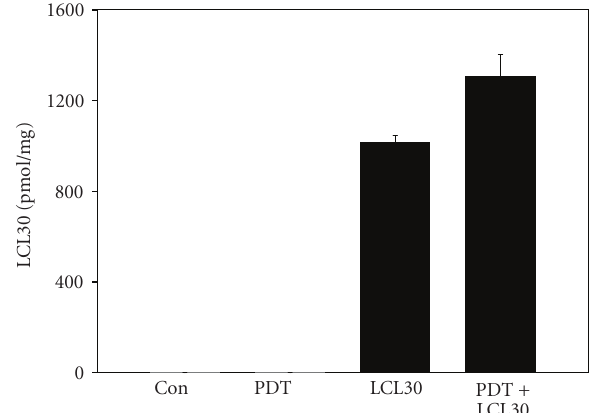
Figure 2: LCL30 is taken up by SCCVII cells treated with LCL30 or (PDT+LCL30). (PDT+LCL30): following overnight exposure to Pc 4 (250nM), cells were treated with LCL30 (1 μ M) for 2 hours, irradiated with red light (200mJ/cm 2 ), and incubated for additional 2 hours. For cells treated with LCL30 alone, the incubation time was 4 hours. Following incubations, cells were collected and processed for MS. The LCL30 levels are expressed as actual values (pmol/mg) and are shown as average ± SEM from four independent determinations.